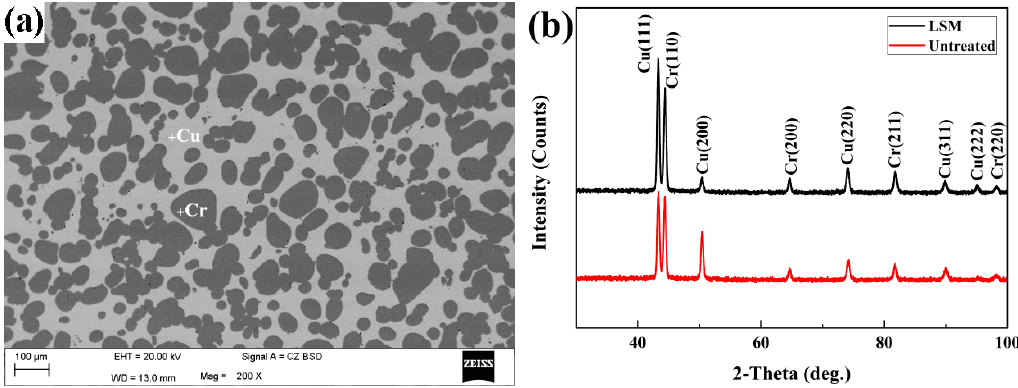
Figure 3. ( a ) Microstructure of Cu-50Cr alloy (backscattered electron image) and ( b ) XRD measurement results of the raw-material and after LSM. results of the raw-material and after